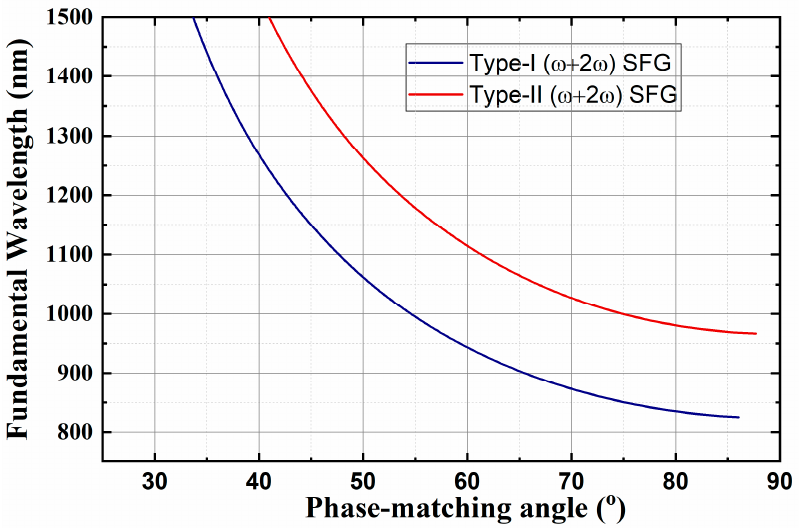
Figure 15. Phase-matching curves for SFG of types I and II in the LYSB crystal. (Reprinted with Figure 15. Phase ‐ matching curves for SFG of types I and II in the LYSB crystal. (Reprinted with permission from ref. [13], copyright 2019 American Chemical permission from ref. [13], copyright 2019 American Chemical Society).